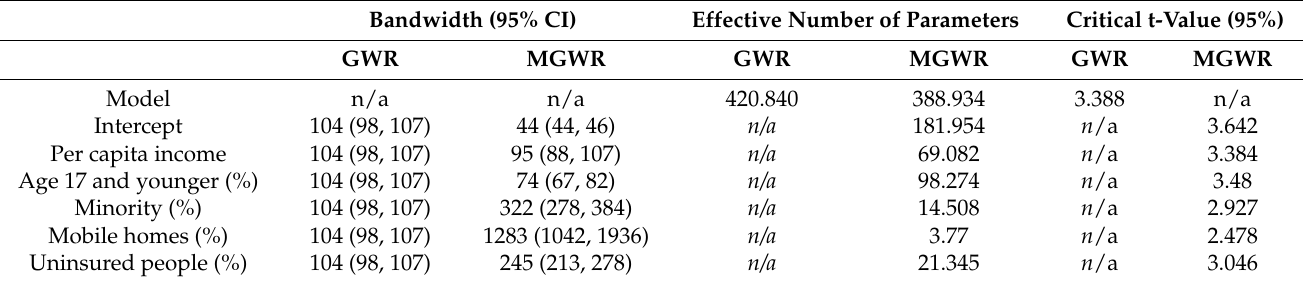
Table 5. Comparison of bandwidths, the effective number of parameters, and critical t-values for GWR and MGWR mod- els.